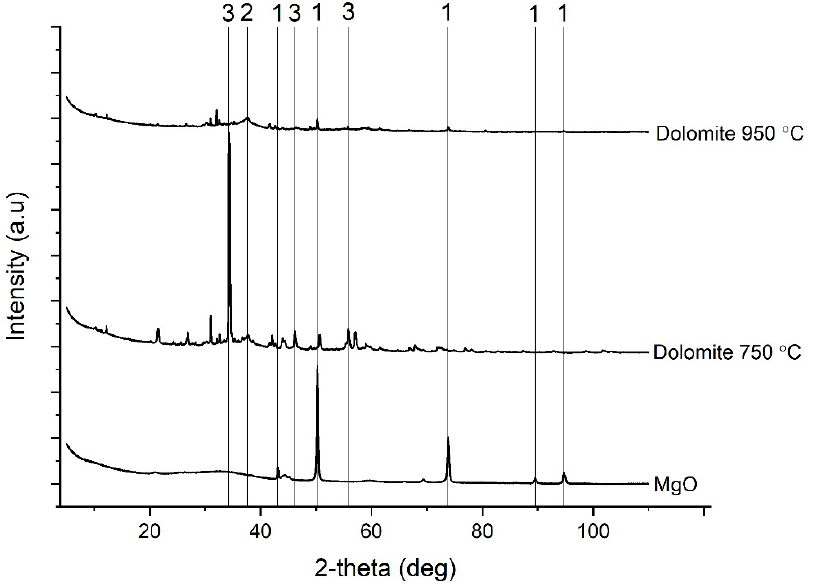
Figure 6. XRD diffractograms of the precipitates after the 4 h experiments (Mg:P:N 1.3:1:2 for MgO and 1.3:2:2 for dolomite): 1 = MgO; 2 = Ca 5 (PO 4 ) 3 (OH); 3 = CaCO 3 .